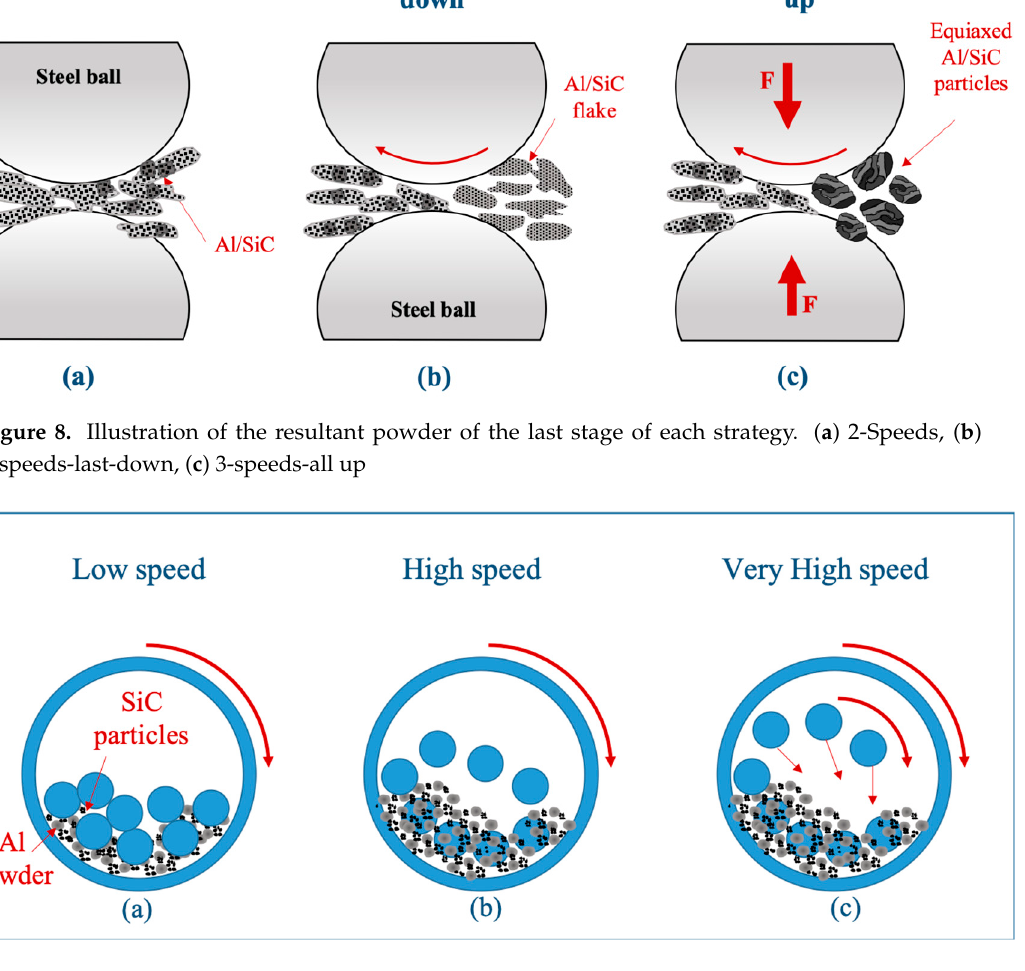
Figure 9. Schematic of the balls motion with increasing speed. ( a ) low speed, ( b ) high speed, ( c ) very high speed.